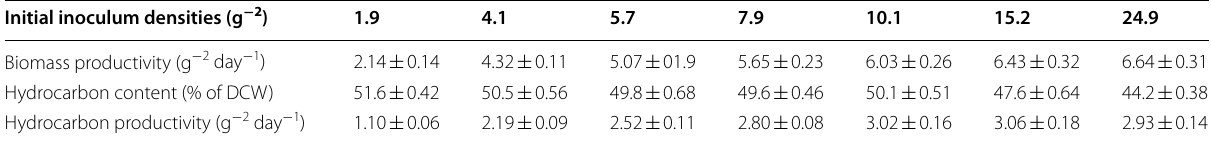
Table 1 Effect of inoculum density on growth and hydrocarbon accumulation of B. braunii SAG 807-1 under attached cul-